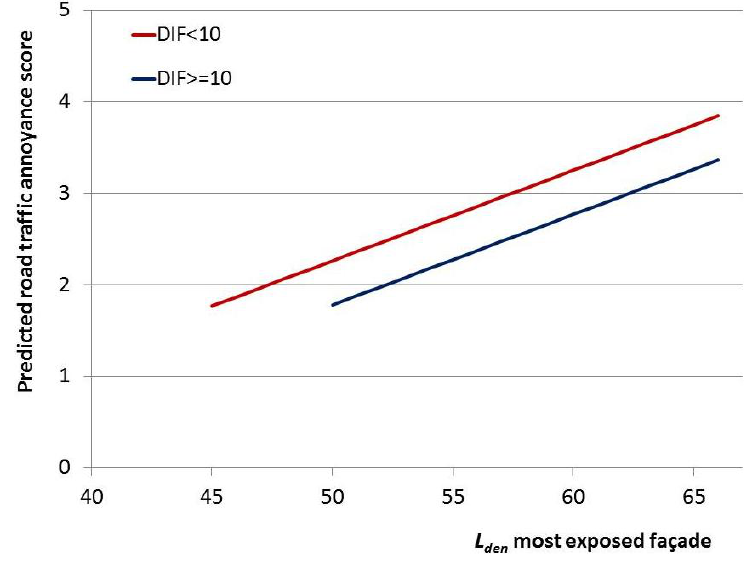
Figure 3. Road traffic noise annoyance score predicted from L difference between L and L in two categories (DIF < 10 dB versus DIF ≥ 10 dB). den,most den,least Results from linear regression